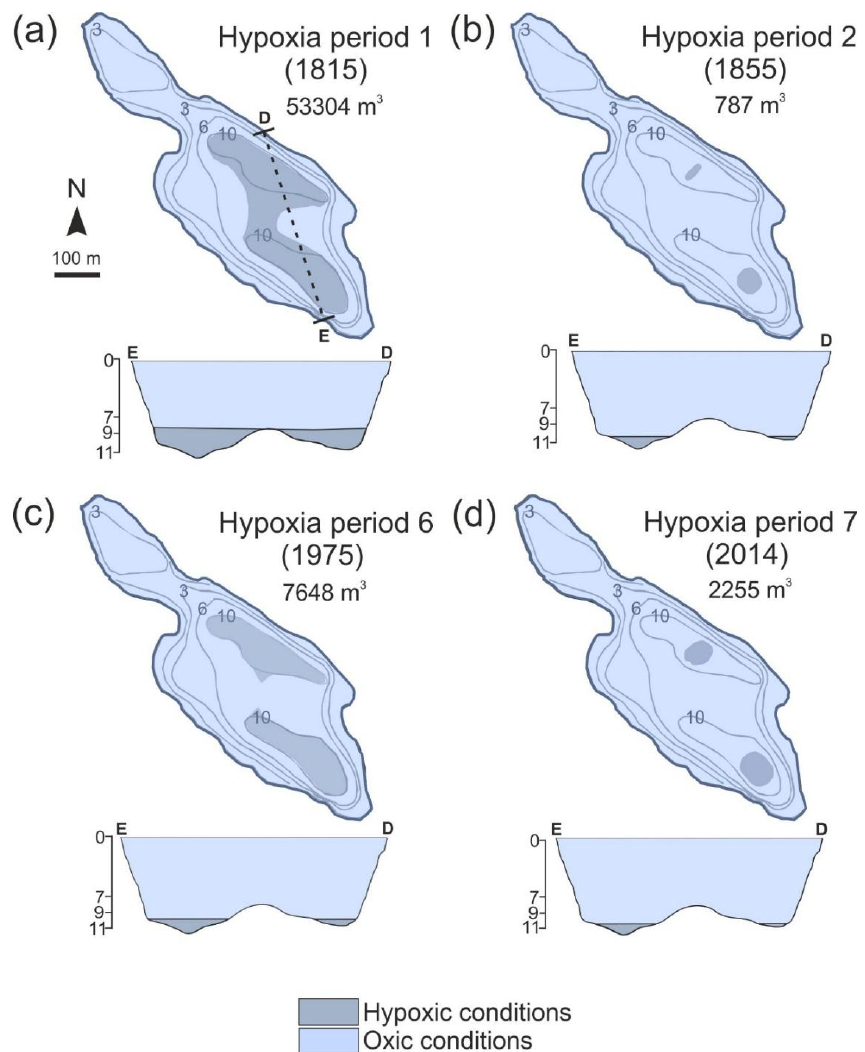
Figure 6. First year of occurrence and volume of hypoxic waters (in m 3 ) for ( a ) hypoxia period 1 in 1815, ( b ) hypoxia period 2 in 1855, ( c ) hypoxia period 6 in 1975, and ( d ) hypoxia period 7 in 2014. Bathymetric cross-sections along the dashed line DE show hypoxic (darker color) and oxic conditions (lighter color). Water depths 7–11 m in the transects are exaggerated by a factor of 25 to better visualize the variations in hypolimnetic hypoxia.